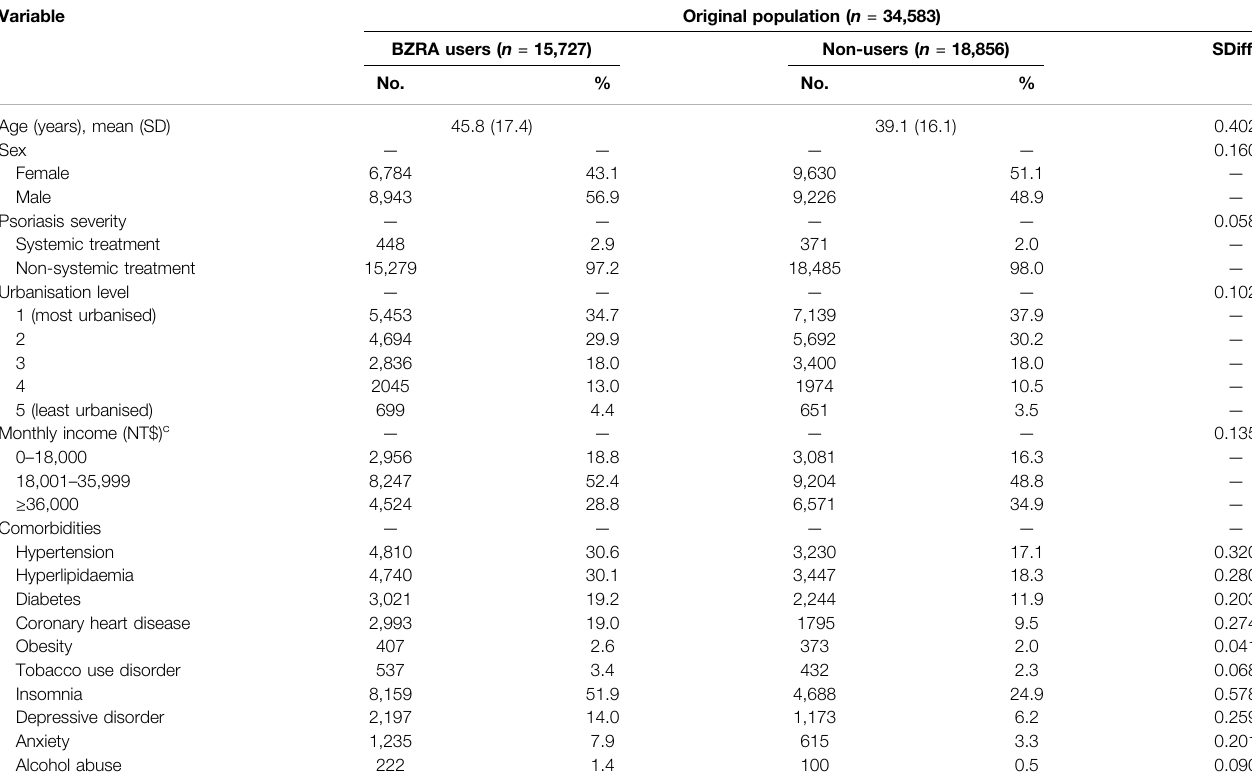
TABLE 1 | Demographic characteristics of the sampled patients at baseline. Variable